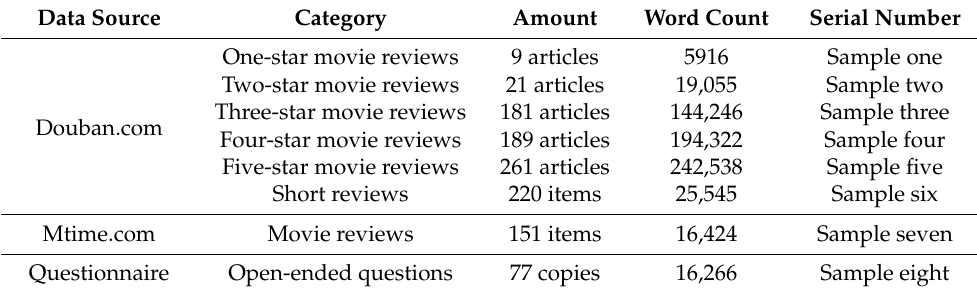
Table 2. The statistical breakdown of study data